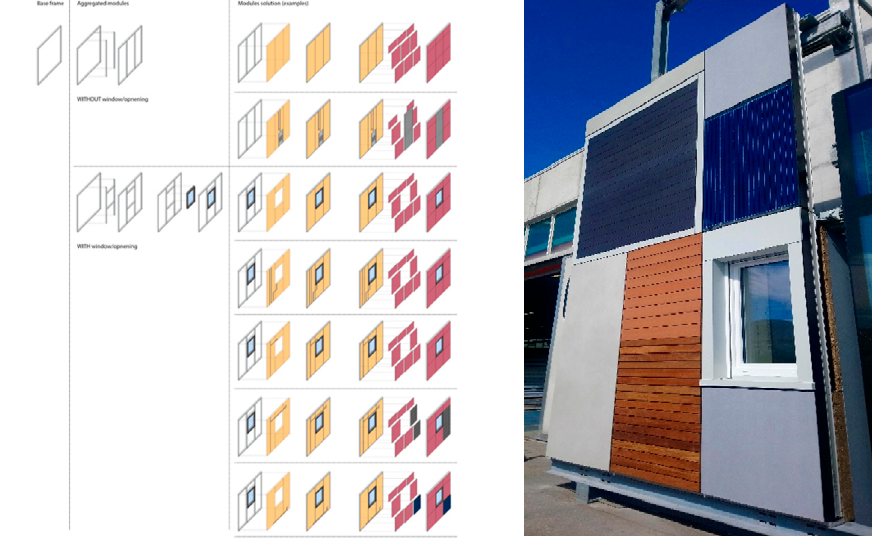
Figure 3. Mock-up of the RenoZEB facade modules and components